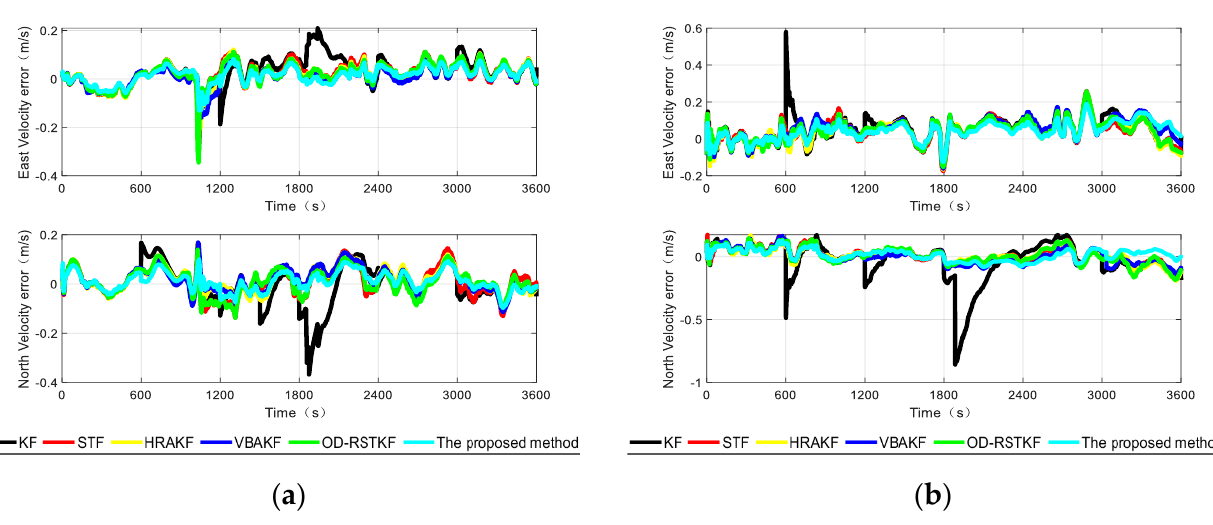
Figure 12. The velocity errors from different algorithms in two segments ( a ) The velocity error of different algorithms in the first test; ( b ) The velocity error of different algorithms in the second test.